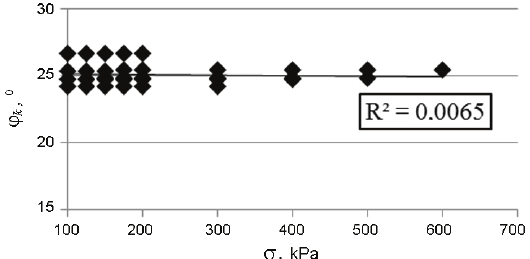
Fig. 14. The angle of internal friction versus vertical stress (results of 18 tests)